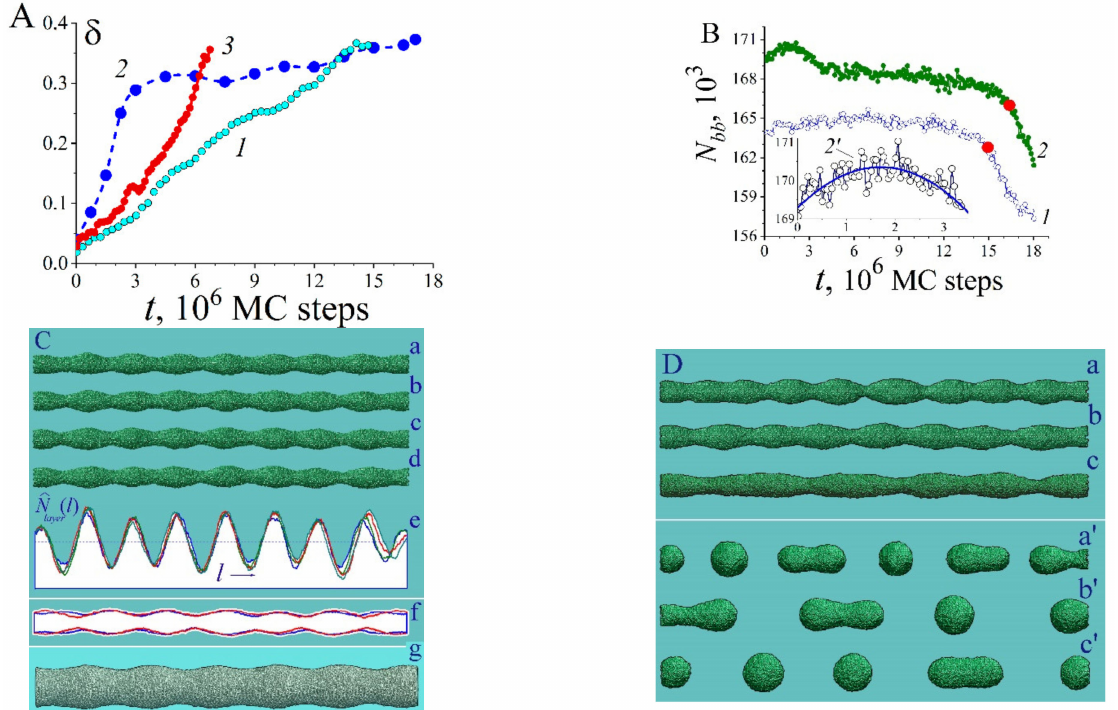
Figure 6. Dynamics of nanowires with (100) orientation in different regimes: ( A ) dependencies of the level of modulation of the cross-section of the nanowire, δ ( t ) , on time: δ = ∆ N 2 N layer is a number of atoms in transverse atomic layers. Initial nanowire radius r nw = 15.5, length L = 700. Curve 1 (cyan circles)— p = 0.7, α = 1 (breakup without external irradiation). Blue circles— p = 0.825, α = 1 (transformation under external irradiation without heating). The red curve (3)— p = 0.825, α = 0.8 (breakup under external irradiation with heating). Dependences δ ( t ) are given up to the first nanowire rupture; ( B ) variations in time of the number of broken bonds, N bb ( t ) , for surface atoms of the nanowire. The parameters for curves 1 and 2 are the same as for curves 1 and 2 presented in Subpart A. The lower inset, curve 2’, represents the initial stage of dependency 2; ( C ) formation of a quasi-equilibrium shape of a nanowire with the pronounced roughening transition. The parameters are the same as shown in subpart ( A ) for the blue curve (2). Configurations (a–d) depict shapes of the nanowire at time moments t = 3, 6, 9, 12 ( × 10 6 ) MC steps. For these time moments, subpart (e) shows the distributions of atoms in atomic layers (100) along the nanowire axis by blue, olive, red, dark cyan curves, respectively: ˆ N layer ( l ) = N layer ( l ) / N layer ( t = 0 ) . Subpart (f) represents a longitudinal section of a nanowire with a larger radius ( r nw = 20 ) at time moments t = 9 × 10 6 (blue curve) and t = 36 × 10 6 MC steps (red curve). Configuration (g) depicts the shape of a thick nanowire: r nw = 35 ( p = 0.825, α = 1; L = 700 ), t = 15.7 × 10 6 MC steps; ( D ) configurations (a–c) depict the nanowire shapes close to the first breakup for regimes (1), (2), and (3) presented in subpart A; t = 13.5, 12, 6.5 ( × 10 6 ) MC steps. For these cases parameter δ ≈ 0.33. Configurations (a’–c’) show the nanowire shapes at the final stages of breakup: t = 27.9, 27.9, 11.7 steps,